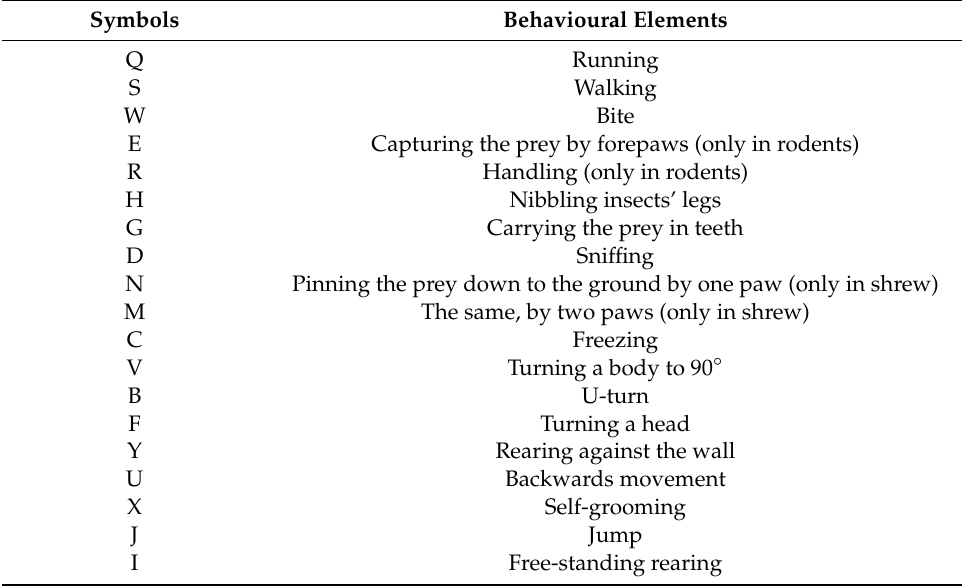
Table A1. An “alphabet” consisting of elements of hunting patterns in species studied.